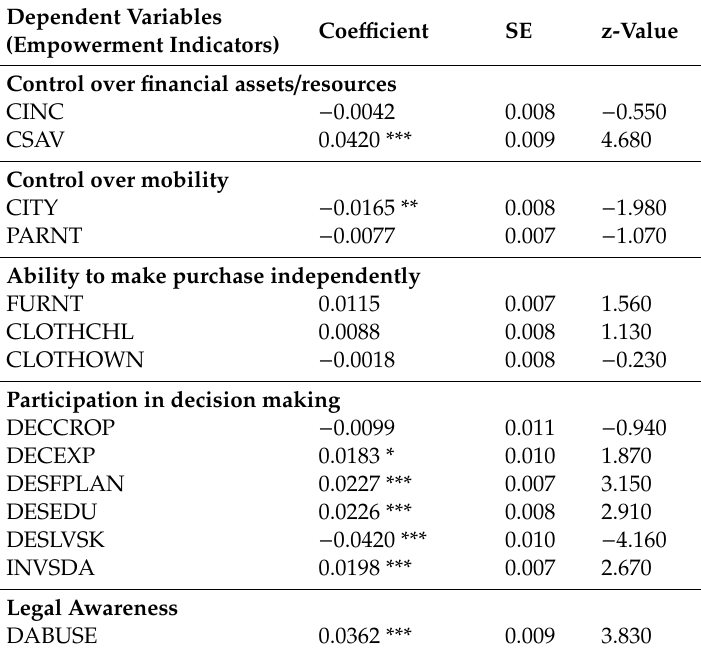
Table 7. Impact of microcredit on di ff erent empowerment indicator.